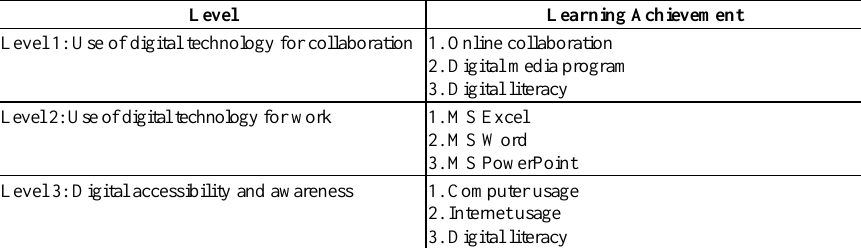
Table 9. Digital Entrepreneurs’